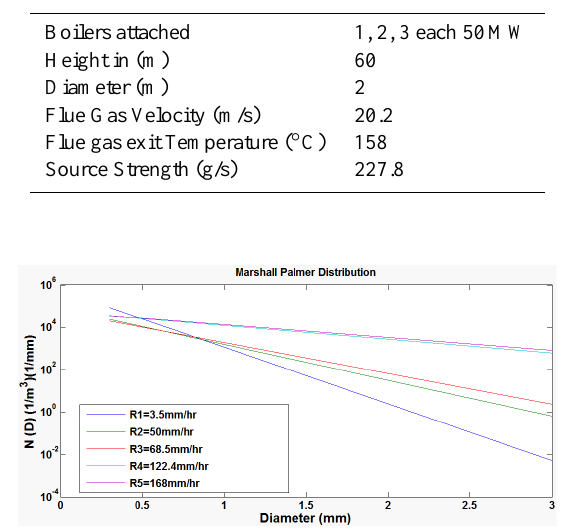
Fig. 3. Marshall-Palmer curves for different rainfall intensities over NLC.